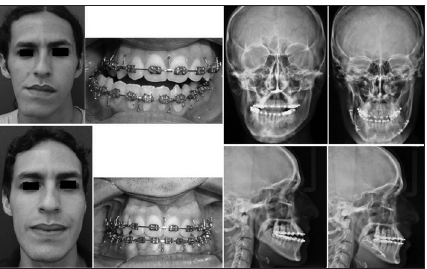
Figura 1. Aspecto clínico e radiográfico antes e após a